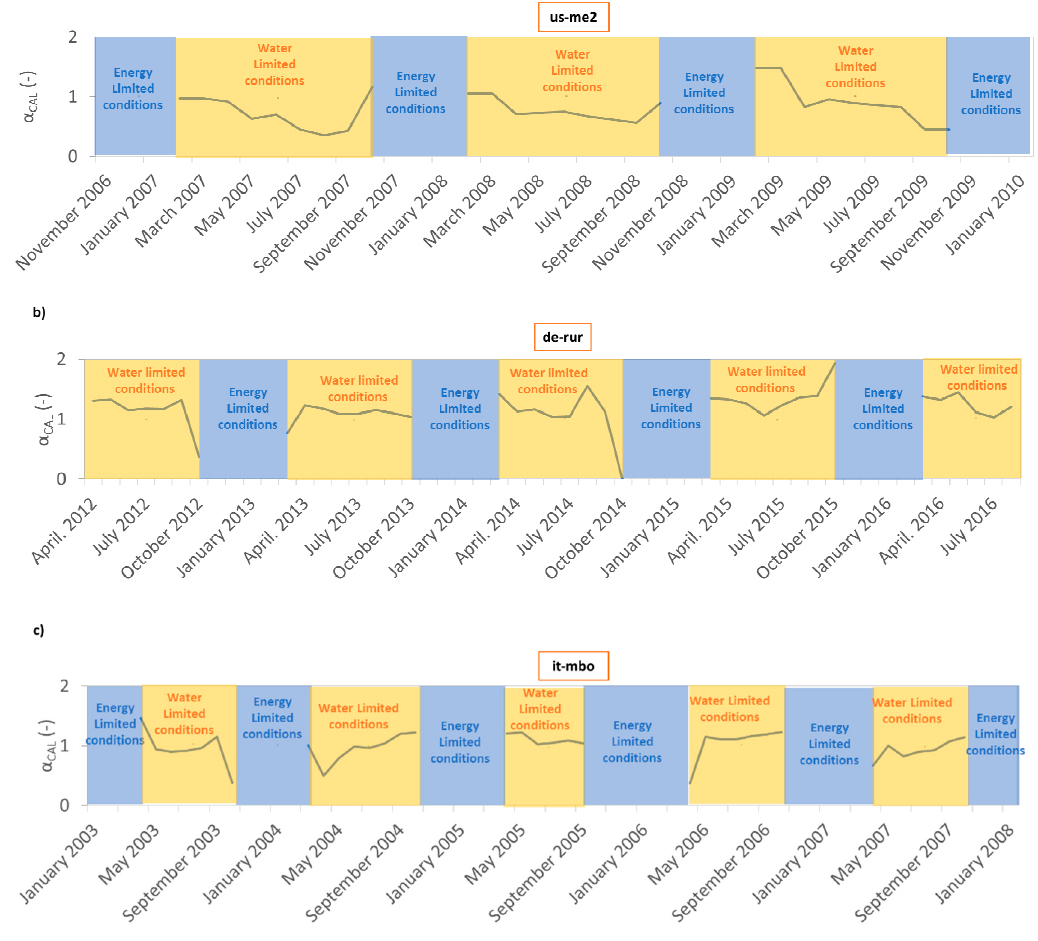
Figure 7. Monthly patterns for the calibrated α CAL coefficient at us-me2 ( a ), de-rur ( b ) and it-mbo during water limited periods.